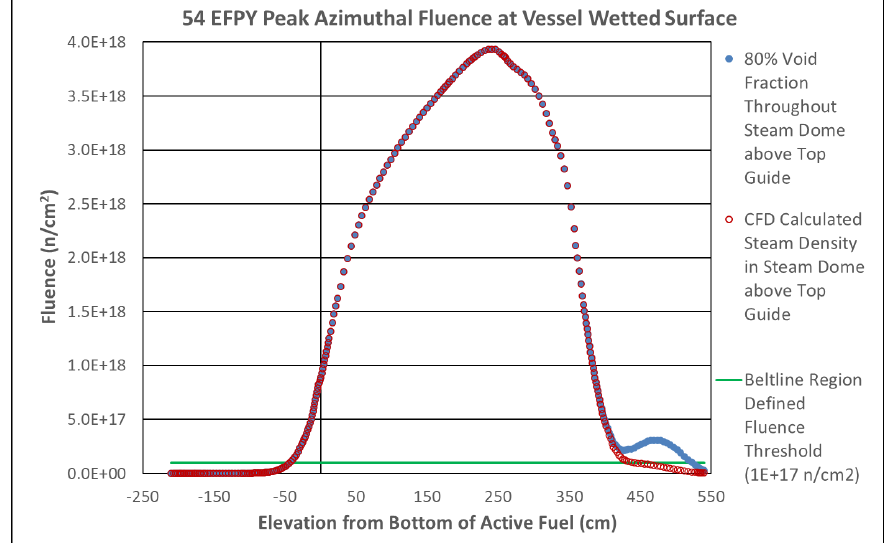
Fig. 4. Peak vessel fast (E>1 MeV) fluence at 54 EFPY. Transport results using CFD calculated water density are compared with the results assuming 80 % void fraction above the grid